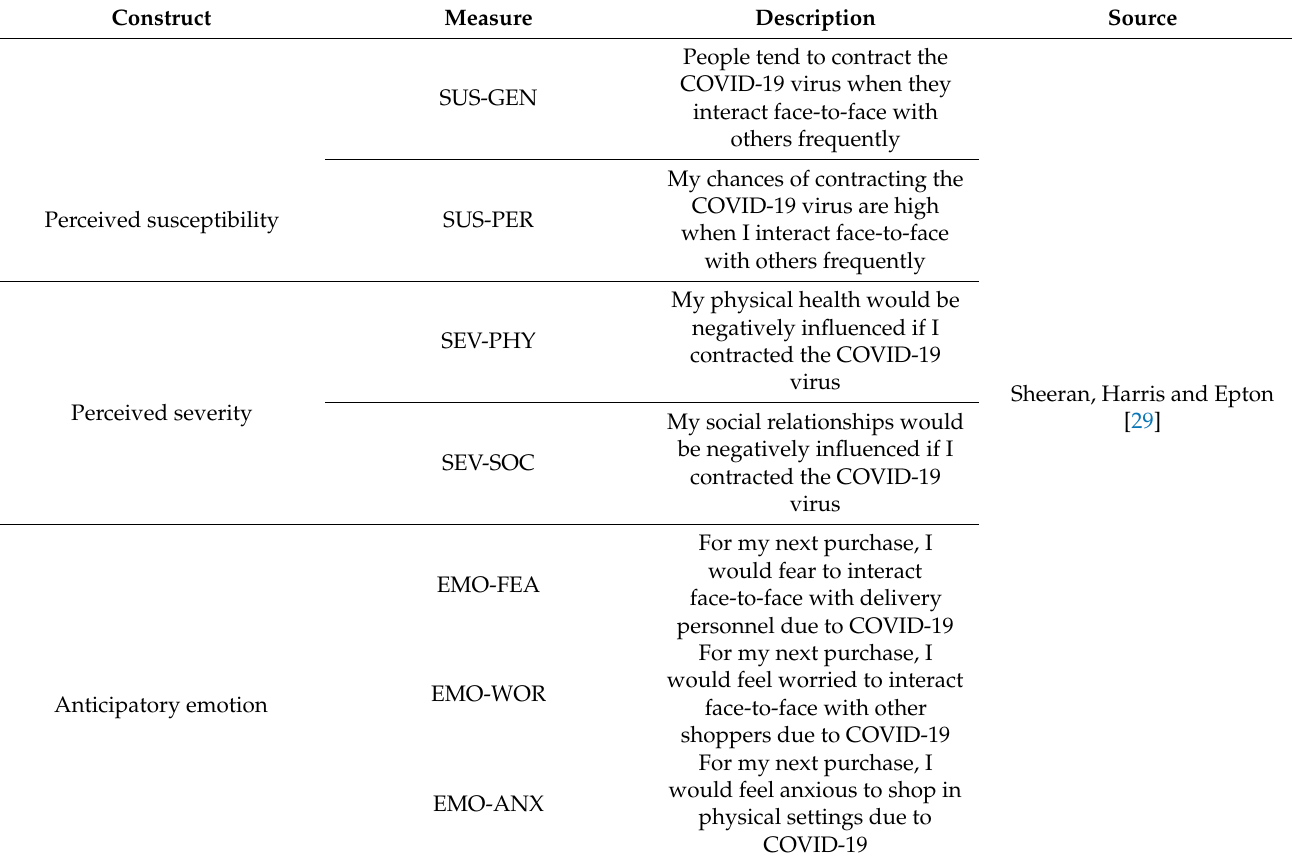
Table 1. Measures and